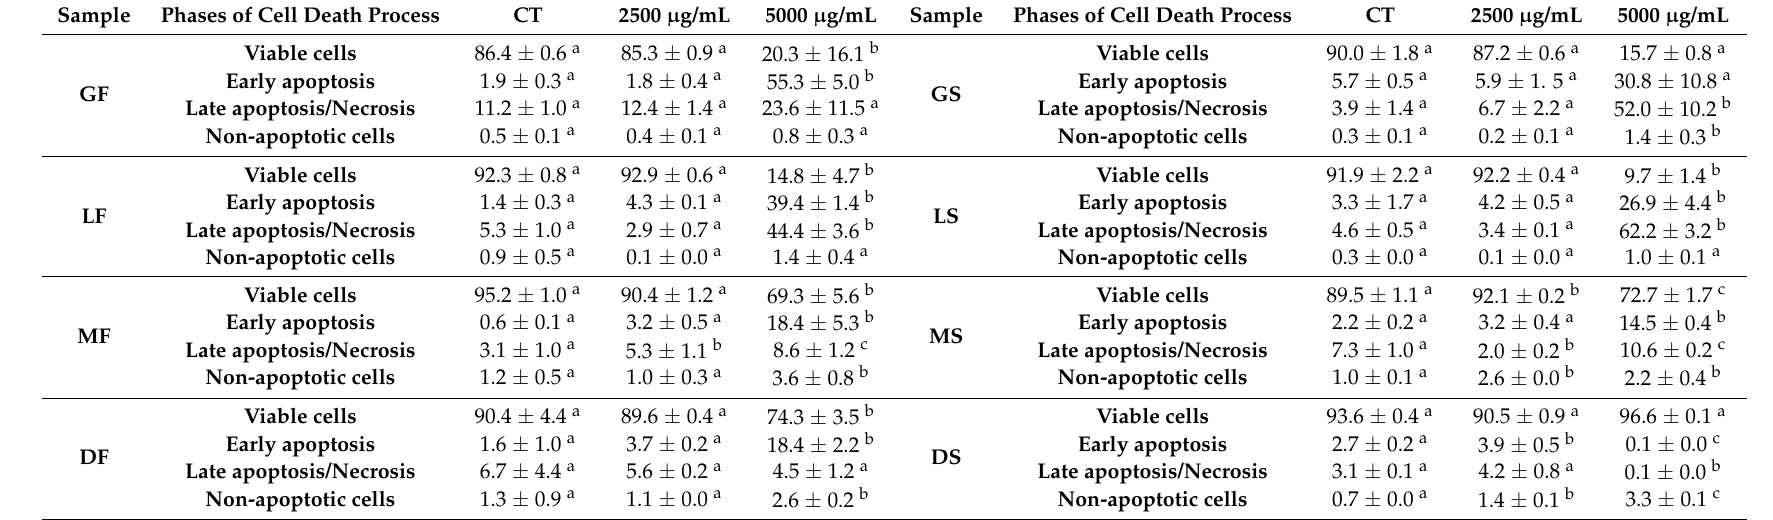
Results are expressed as the percentage of total cells. The data represent mean ± standard deviation values of triplicate experiments. Tukey test: (a–c) different letters in the same phase of death process and extract means that samples are different ( p < 0.05) and same letters indicate samples are the same ( p > 0.05). Abbreviations: GF—green freeze-dried,